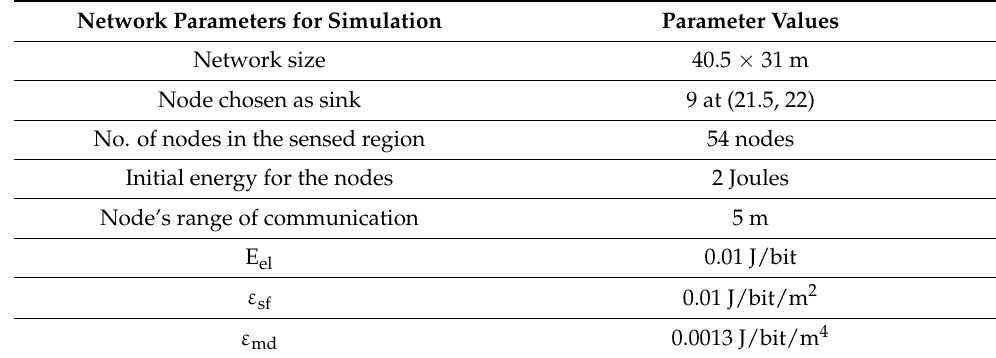
Table 2. Network parameters in the proposed algorithm.